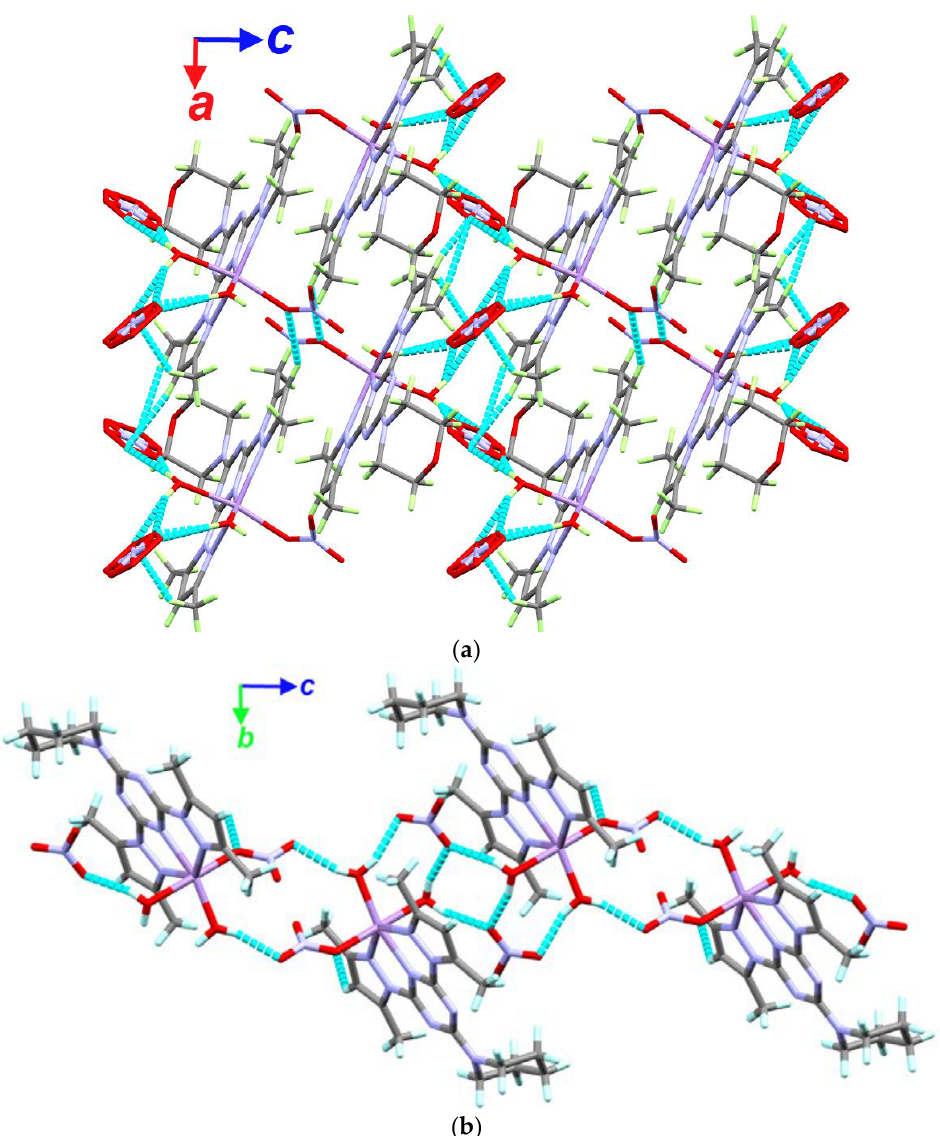
Figure 4. H–bond networks in 1 ( a ) and 2 ( b ) . Table 4. Anion– π contacts in complexes 1 and 2 .